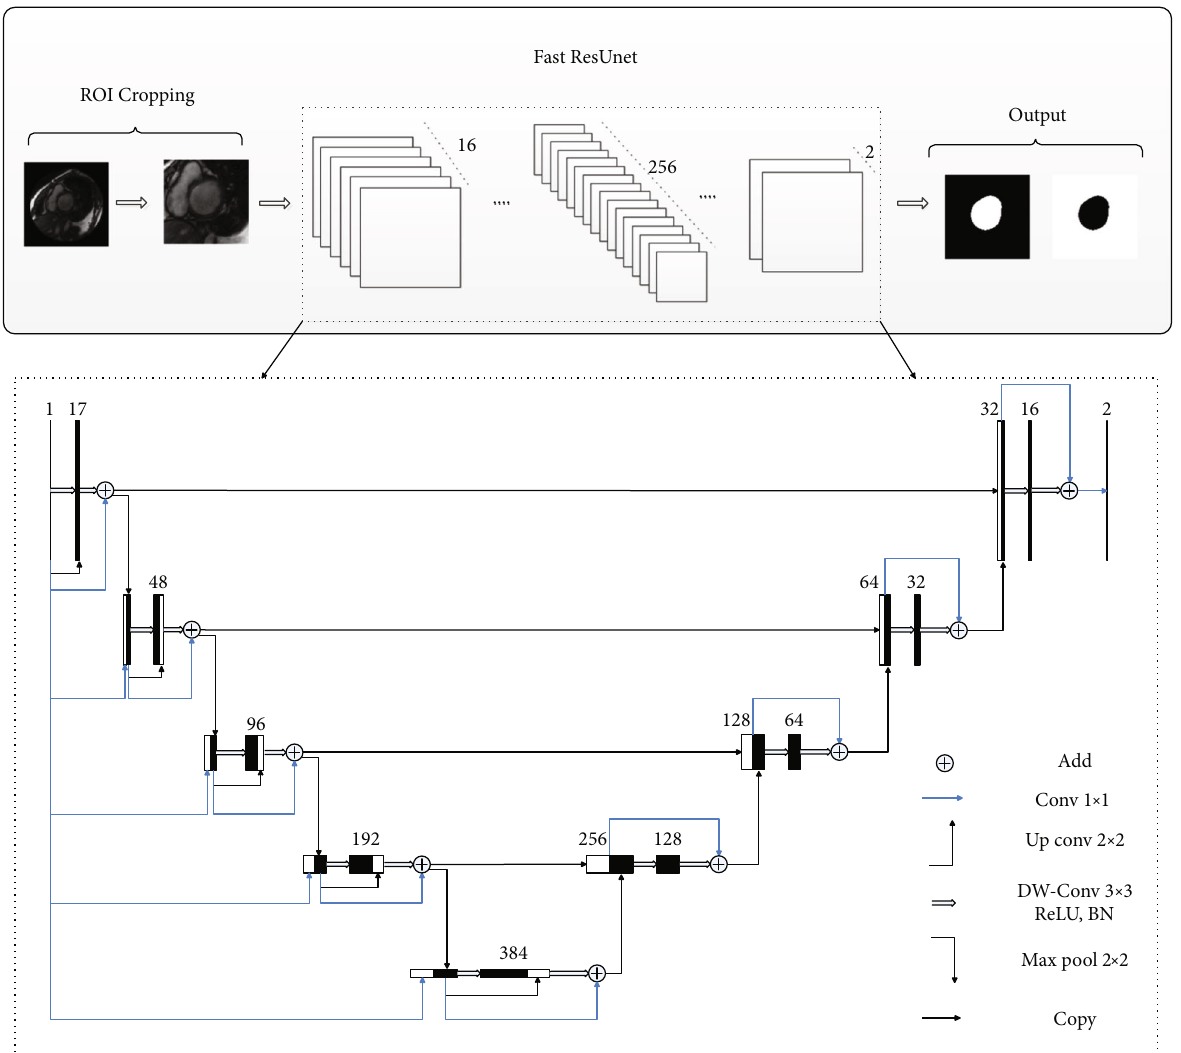
Figure 1: The proposed segmentation model with labels Add (addition), Conv (convolution), DW-Conv (depth-wise convolution), BN (batch normalization), and ReLU (recti fi ed linear unit).